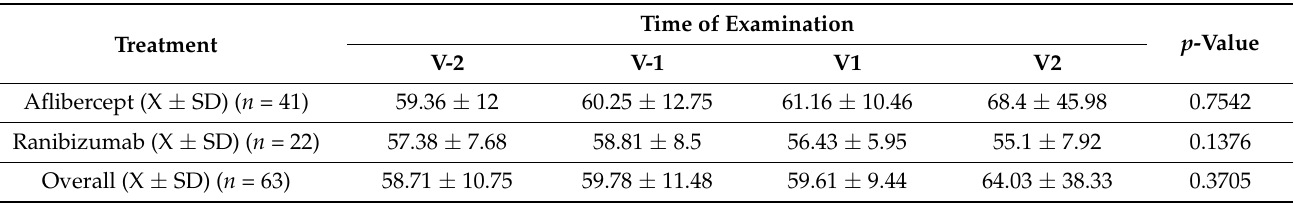
Table 2. Visual acuity (ETDRS chart) during follow-up.